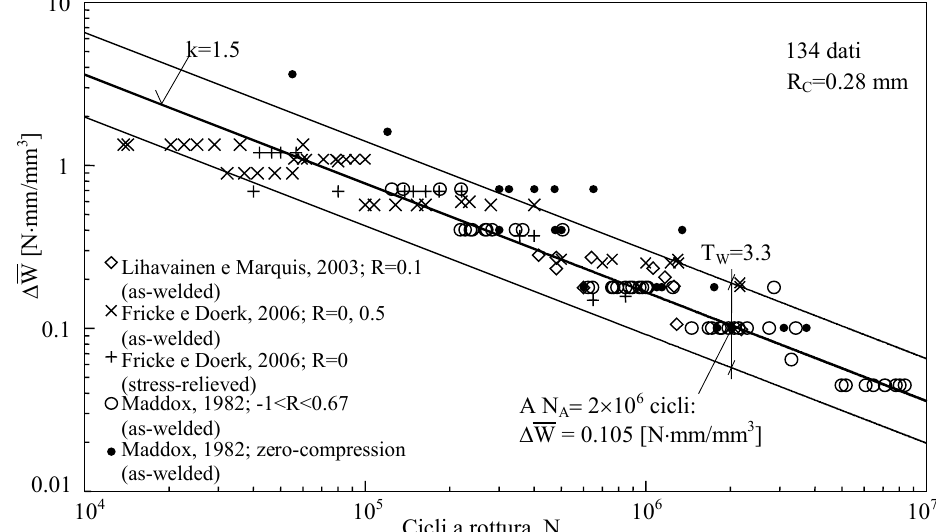
Figura 7. Resistenza a fatica di giunti saldati in acciaio strutturale di geometria complessa in termini di densità di energia locale; i dati originali sono riportati nei riferimenti [11-13]. Confronto con la banda di dispersione proposta da Lazzarin et al. [5] (P S